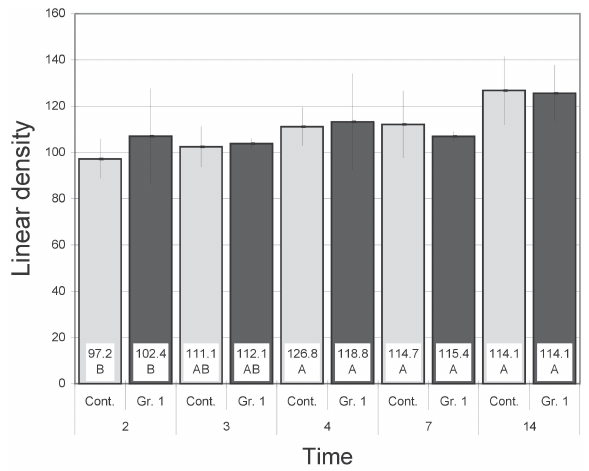
FIGURE 2 - Means, Standard errors and confidence level of means of Linear Density in the different times and treatments studied. Bars with the same letter indicate means of times that do not differ